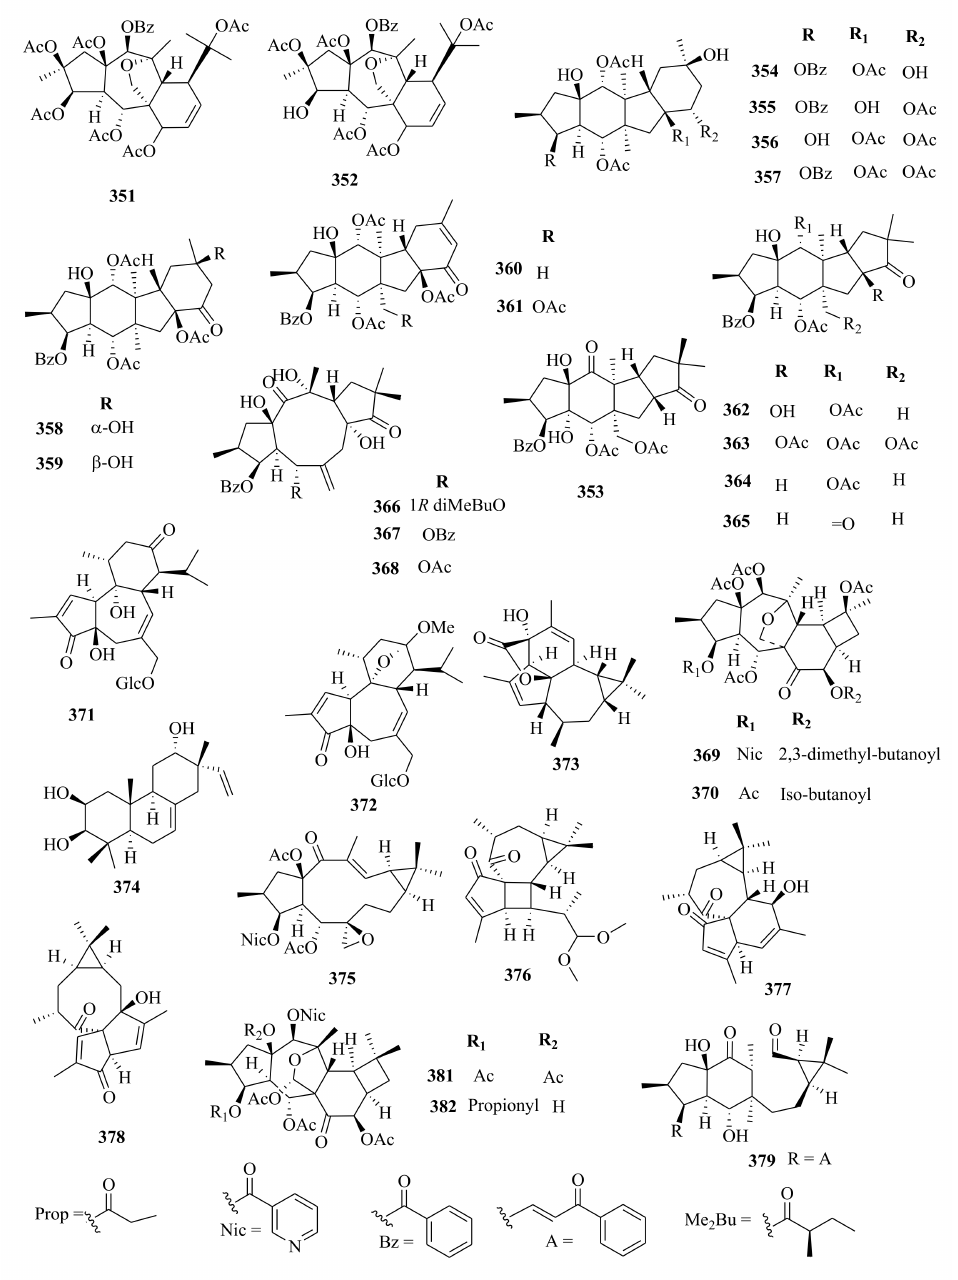
Figure 15. Structures of myrsinol, tigliane, paraliane, pepluane and presegetane